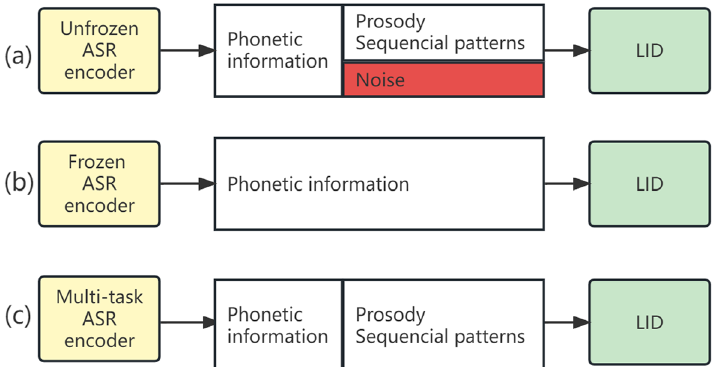
Fig. 3 Three types of features fed into LID. a End-to-end LID tends to learn hybrid-level knowledge, which includes noise. b A pretrained frozen ASR encoder can only provide phonetic features for LID. c Ideally, a pretrained unfrozen ASR encoder should provide noiseless hybrid-level